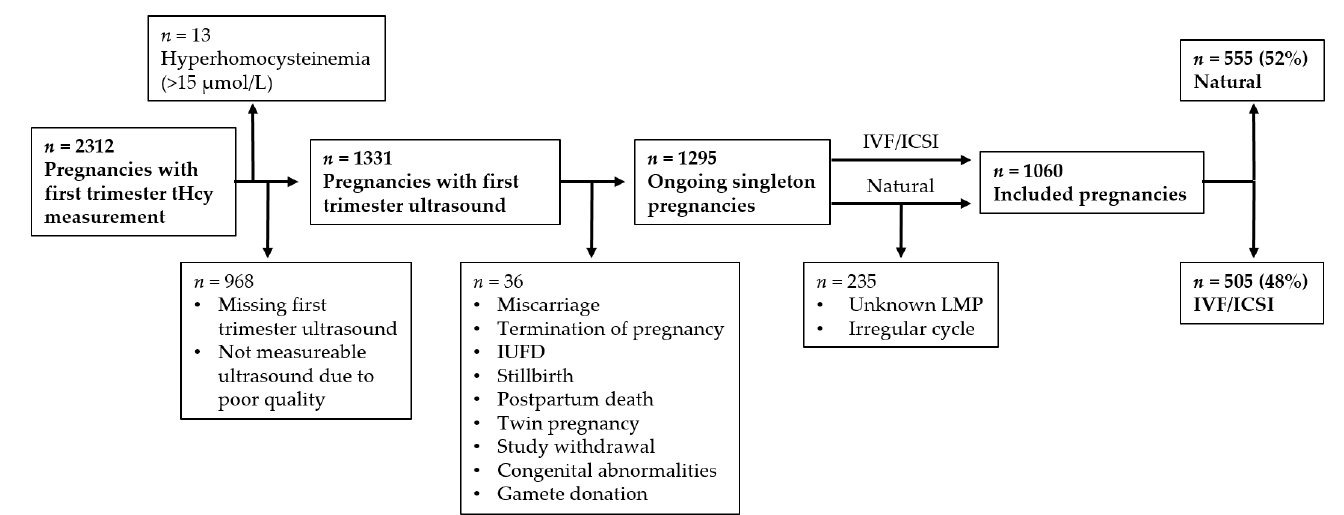
Figure 1. Flowchart of included and excluded population (2010–2020) based on predefined criteria. Abbreviations: ICSI, intracytoplasmic sperm injection; IUFD, intrauterine fetal death; IVF, in vitro fertilization; LMP, last menstrual period; tHcy, total homocysteine.